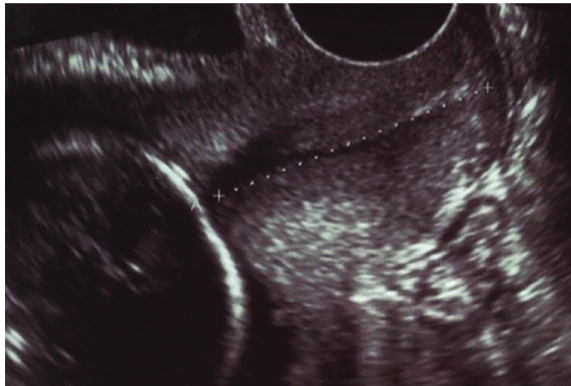
Figure 1: Transvaginal ultrasound image of the uterine cervix.